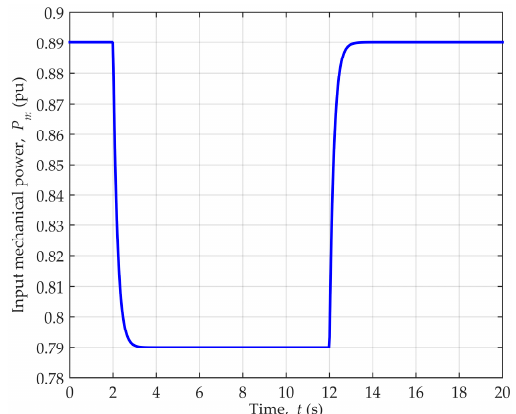
Figure 13. Input mechanical power change.